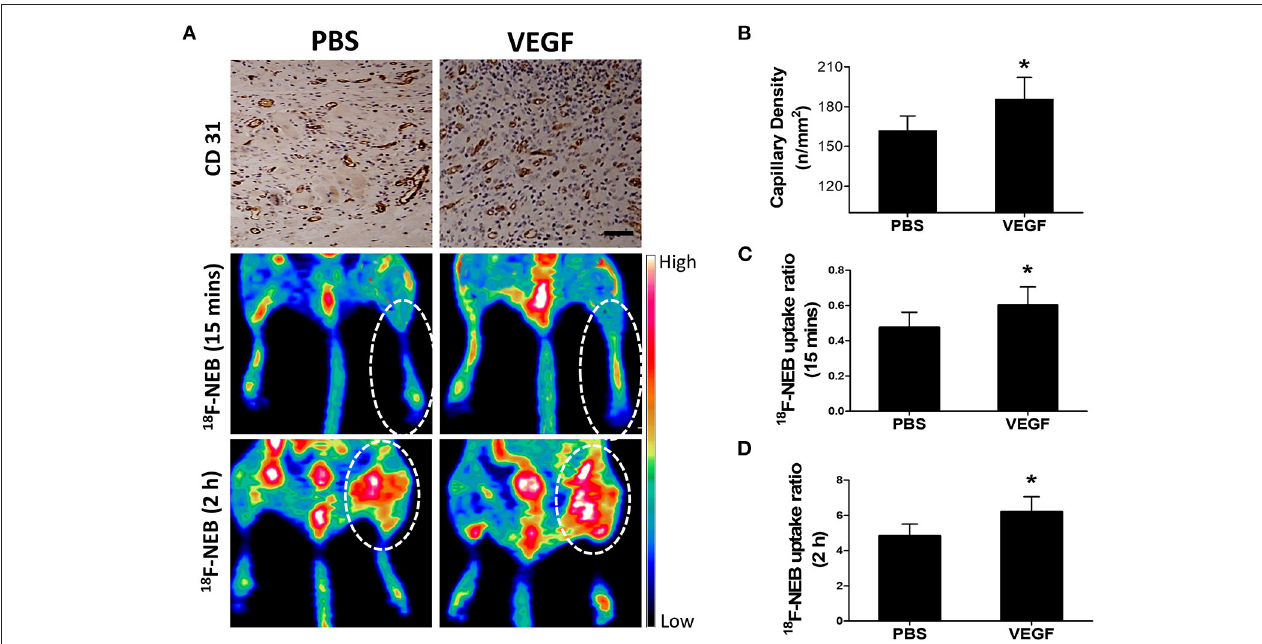
FIGURE 6 | Effect of VEGF-induced angiogenesis on vascular permeability in ischemic limb at day 7 post-operation. (A) Immunohistochemical staining of CD 31 (panel left) to detect angiogenesis in the ischemic skeletomuscular tissue sections; representative PET images of ischemic hindlimb at early phase (15 min: middle panel) and late phase (2 h: right panel) after 18 F-NEB tracer injection in the VEGF-treated (VEGF) and PBS-treatment (PBS) groups. (B) Quantitative analysis of CD31 capillary density at day 7 post-operation in mice treated with VEGF or PBS (* P < 0.05, vs. PBS; P = 0.015). (C,D) Quantification of the signal intensity from in vivo PET imaging in early phase (C) ( P = 0.027) and late phase (D) ( P = 0.005) after 18 F-NEB tracer injection in mice treated with VEGF or PBS (* P < 0.05 vs.